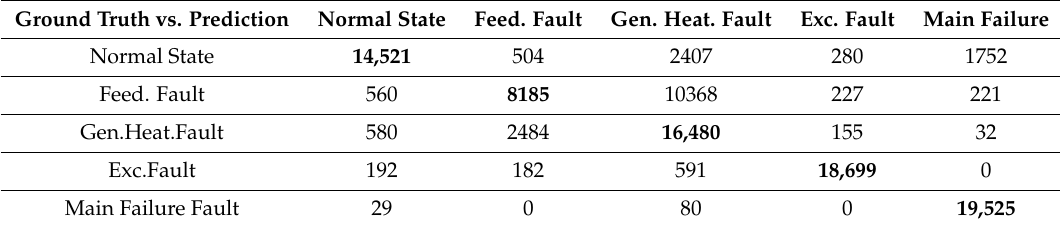
Table 3. Multiclass LSTM-SAE Confusion